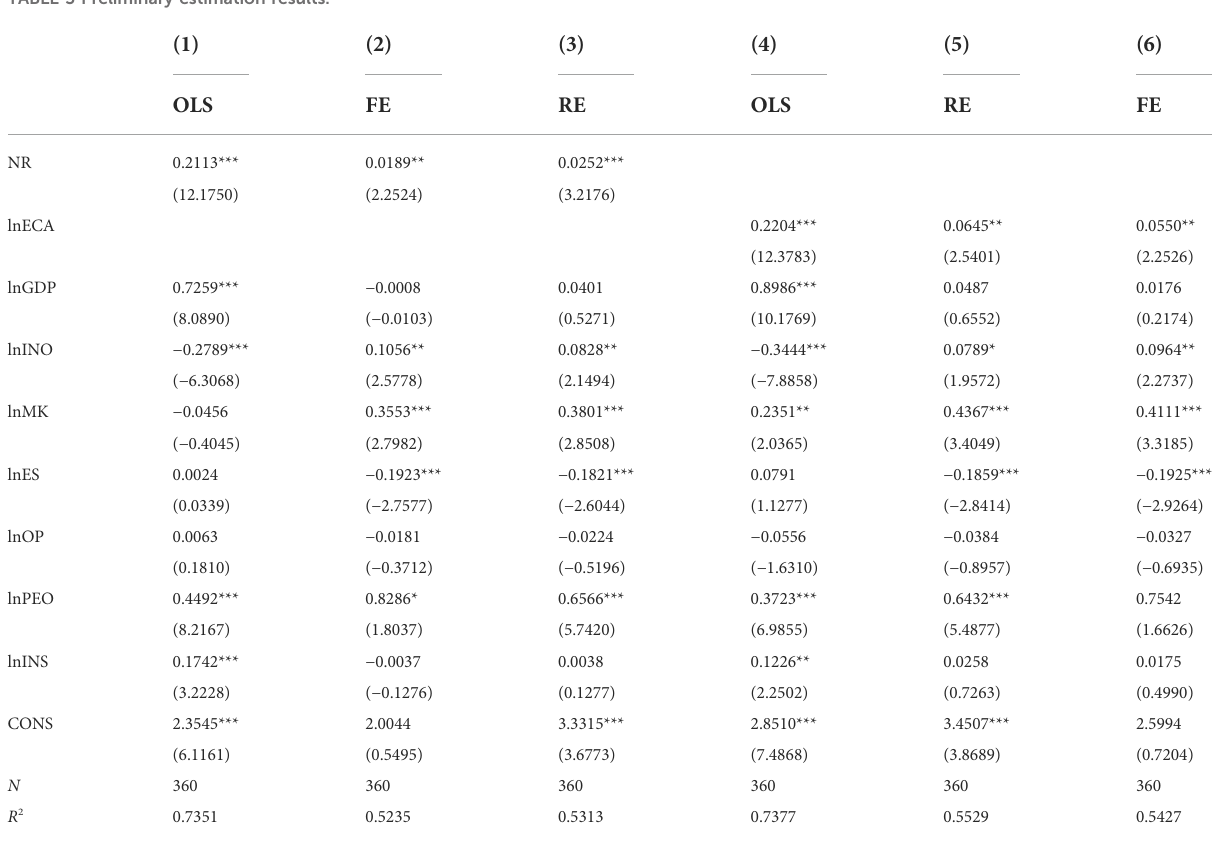
TABLE 3 Preliminary estimation